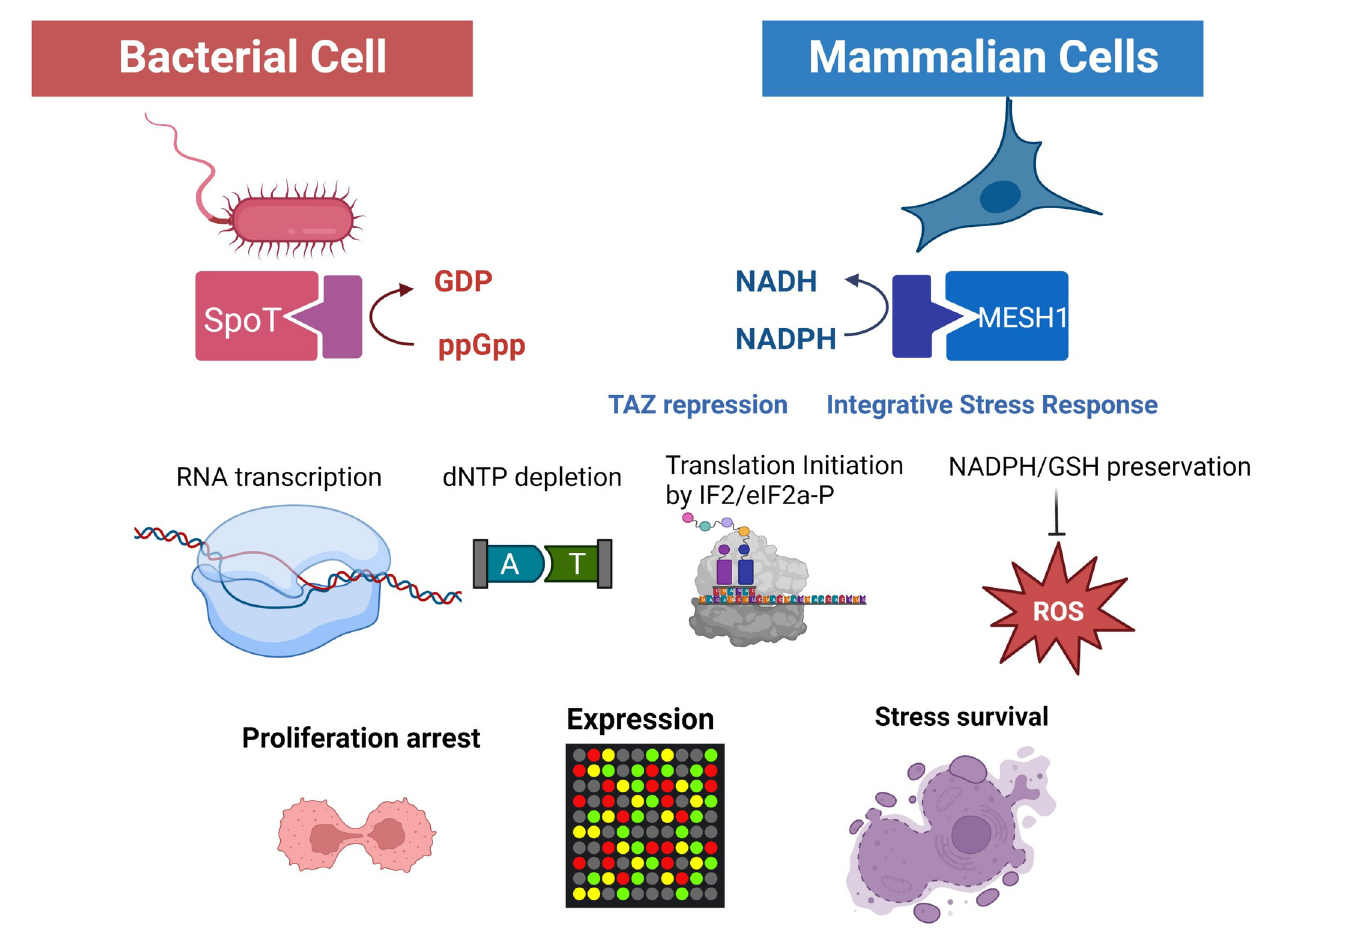
Fig 1. Distinct substrates of SpoT/MESH1 and the conserved biological processes and phenotypic features of the bacterial (left) and mammalian (right) stringent response.